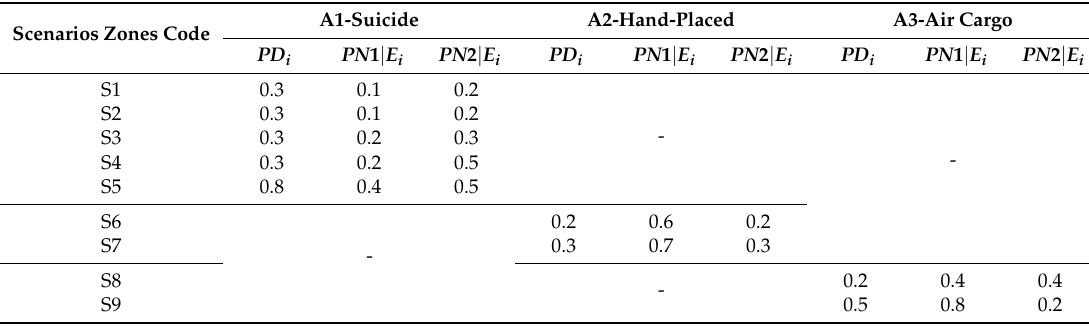
Table 4. Security zones and countermeasures.